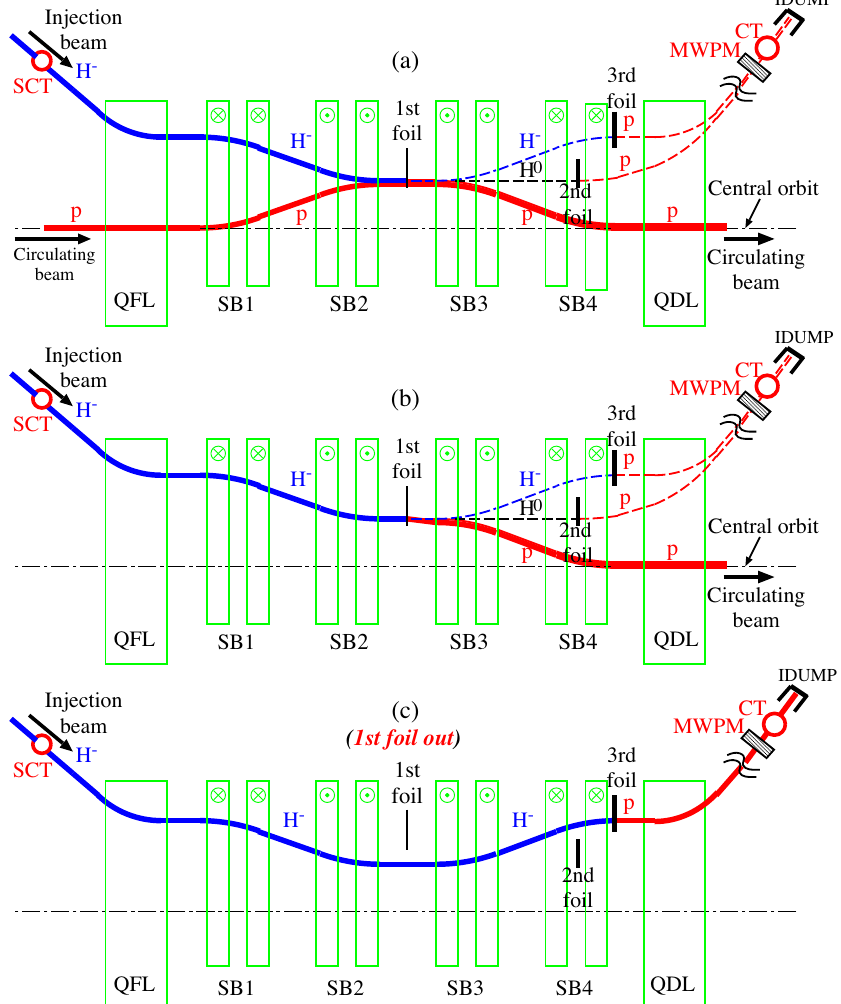
FIG. 7. RCS operation modes used in the present study for quantitative measurement of stripper foil degradation. In the circulating mode (a), the waste beams in total are measured online by the CT during RCS operation. For detailed studies of stripper foil degradation, the H − and H 0 yields are separately and independently measured by both CTand the MWPM in the single-pass extraction mode (b). The H − and H 0 beam profiles are simultaneously measured by the MWPM as they are separated by about 80 mm from each other. However, the measurement by the CT needs two steps. First, the H − and H 0 are measured together, and then the third foil is removed to measure only the H 0 yield, from which the H − yield is obtained. The H − and the H 0 yields measured in mode b are divided by the injection beam yield measured in the injection beam dump mode (c) to obtain each charge fraction. Similarly, the total charge fraction during beam operation mode a is also obtained. The injection beam upstream of the first foil is also always taken together by using an SCT to take into any fluctuation of the injection